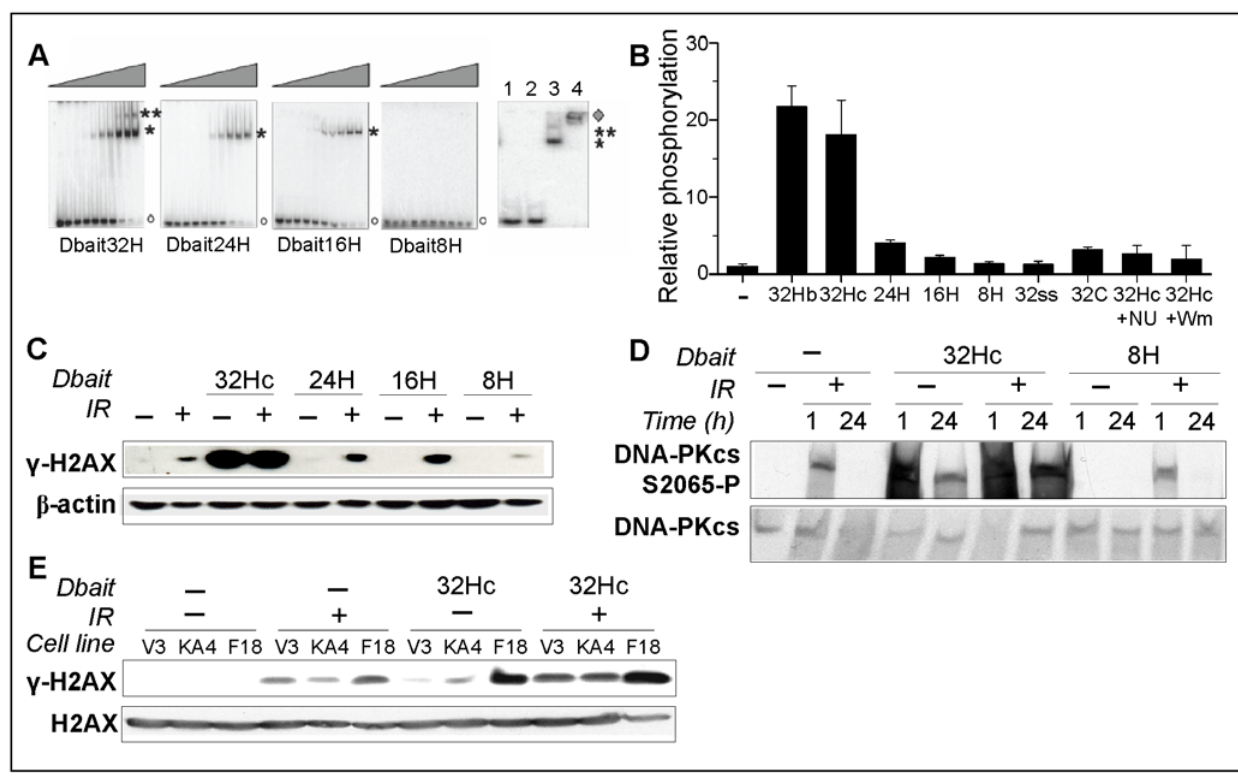
Figure 1. DNA-PK activation and H2AX phosphorylation by Dbait treatment. (A) Various 32 P-labeled Dbait molecules (32H, 24H, 16H, 8H), were incubated with increasing amounts (0-320 ng/ml) of Hep-2 nuclear extract and analyzed on polyacrylamide gels. Asterisks indicate one or two dimer shift. Antibodies against Ku80 were added prior to migration to confirm by supershift that the bands indicated by asterisks contained Ku80 protein: Lane 1, 32H; lane 2, 32H + anti-Ku80; lane 3, 32H + nuclear extract; lane 4, 32H + nuclear extract + anti-Ku80. The diamond indicates the supershifted band of Dbait–Ku complexes bound by anti-Ku80. (B) Stimulation of DNA-PK kinase activity by 20 mM of various Dbait molecules was measured in 1.5 m g HEp-2 nuclear extract. When indicated, inhibitors NU7026 (NU) and wortmannin (Wm) were preincubated with extract 5 min prior to 32H addition (hatched). Data represent the mean value and standard deviation of at least three independent experiments. (C-E) Cells were transfected (5 h) with different Dbait molecules as indicated and irradiated (10 Gy) or not. If not indicated otherwise, proteins were extracted 1 h after end of treatment for western blot analysis. (C) HEp-2 cell lysates were probed for c -H2AX and b -actin. (D) Immunoblot of phosphorylated DNA-PKcs; total DNA-PKcs was revealed on a separate membrane. (E) V3 (DNA-PKcs -/- ), KA4 (DNA-PKcs kinase deficient) and F18 cells (DNA-PKcs proficient) were treated as indicated and the lysates were probed for c -H2AX and total H2AX.